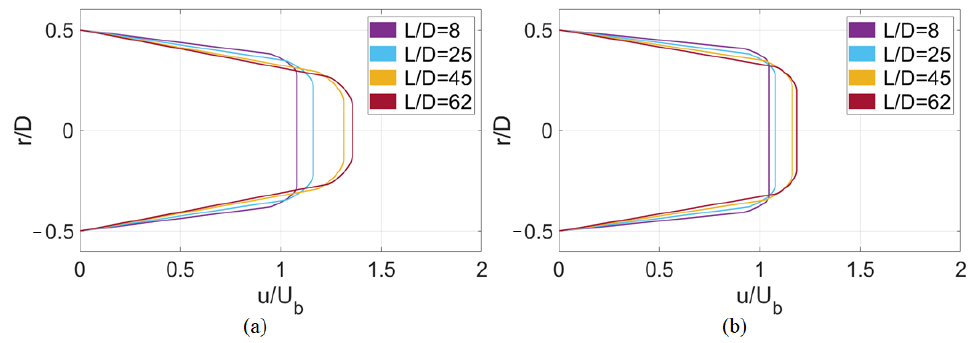
Figure 5. Distribution in space of the inlet velocity at the systolic peak for different lengths of the inlet duct: ( a ) T = 1.14 s and SV = 41.4 mL; ( b ) T = 0.67 s and SV = 133.8